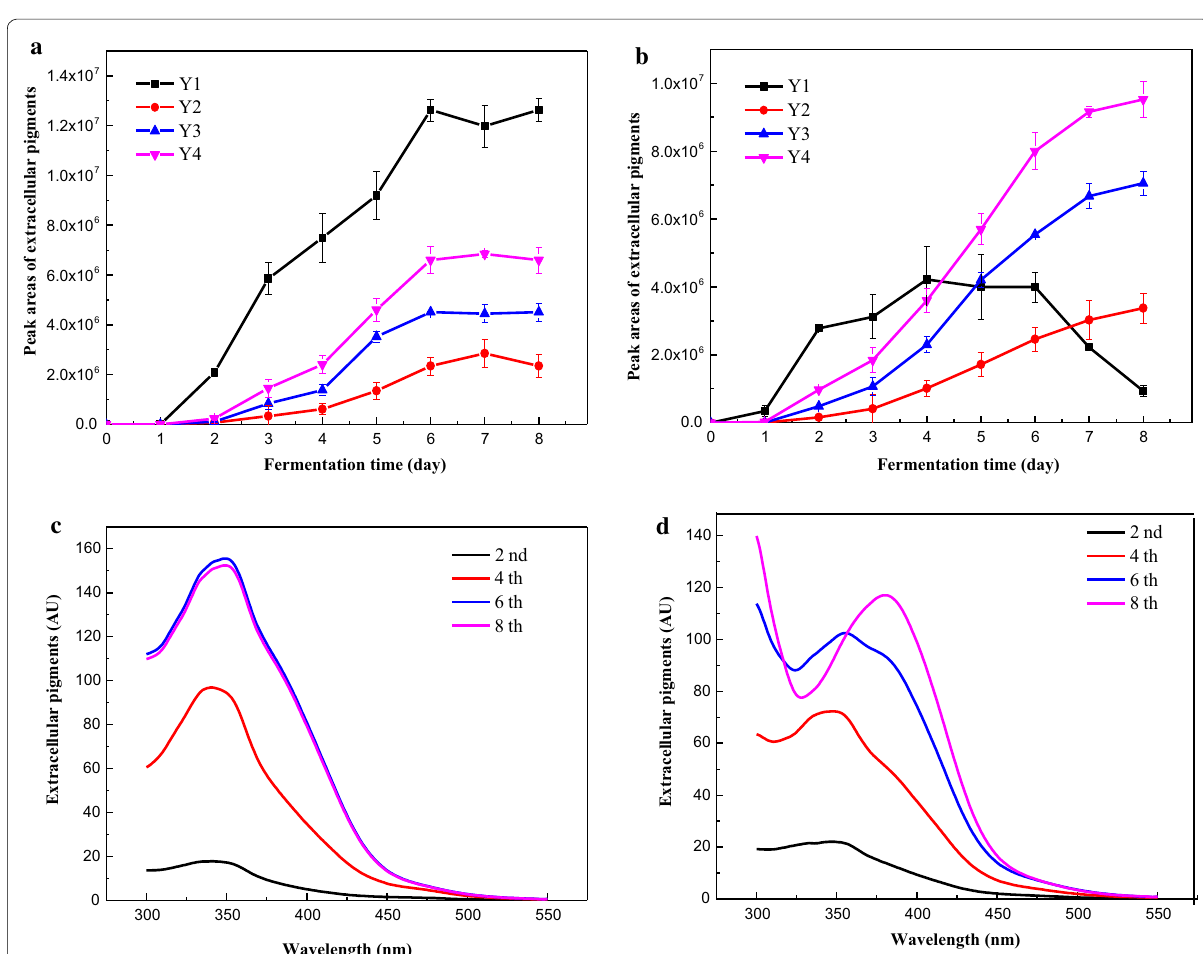
Fig. 3 Metabolism rules of the four water-soluble yellow pigments under different fermentation temperatures. a and b Peak areas of the four water-soluble yellow pigments. c and d UV–Visible spectra of extracellular pigments on 2nd, 4th, 6th and 8th day. a and c 30 °C. b and d 35